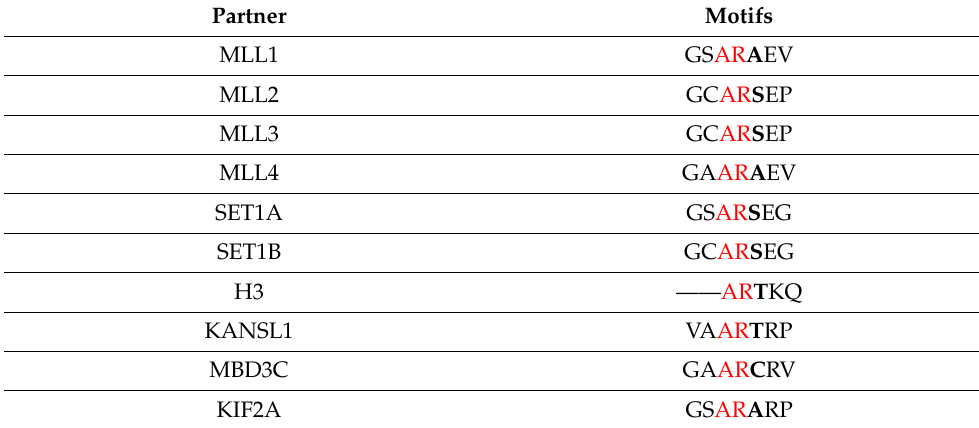
Table 3. Characterized Win